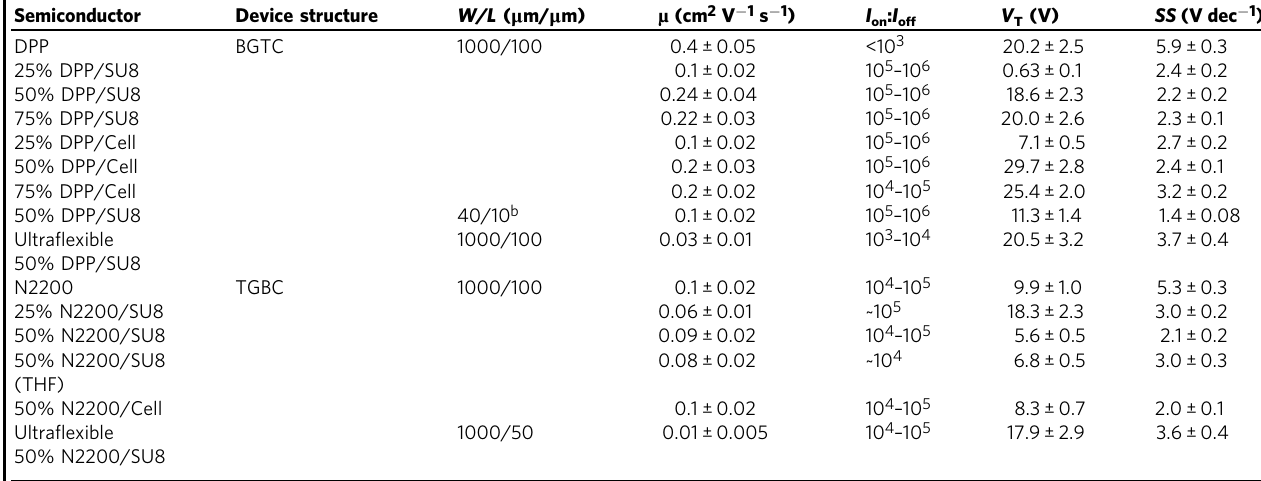
Table 1 Performance metrics of selected TFTs based on pristine semiconductor and patterned polymer blend fi lms a . Semiconductor Device